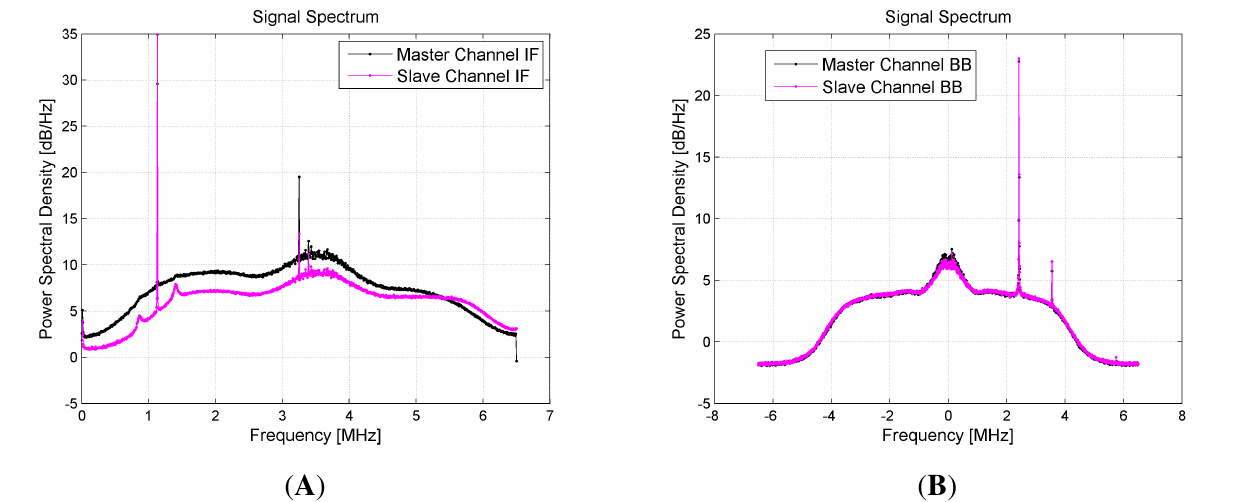
Figure 7. Comparison of the estimated power spectral densities of the signals at the two channels of both FEs, generated through a hardware signal generator and supplied to the FEs input ports through a wired RF connection. ( A ) Channel IF; ( B ) Channel